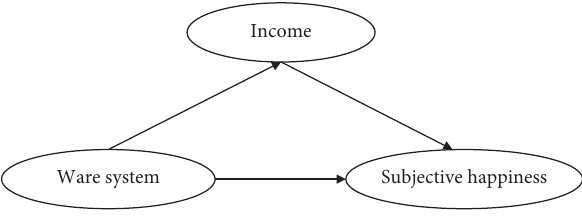
Figure 3: Research framework.